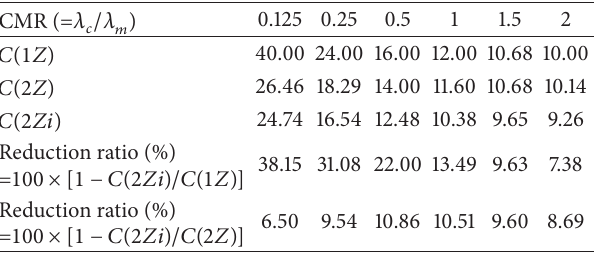
Table 1: Signaling cost with respect to